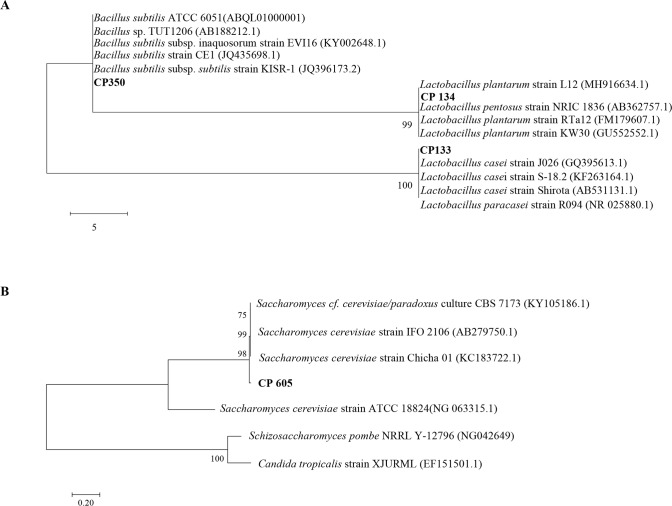
Molecular phylogenetic analysis showing the relationship of strains of CP133, CP134 and CP350 based on 16S rRNA A. and CP605 based on ITS B. using the maximum-likelihood method [32, 33]. Bootstrap values of 500 replicates are shown at the tree nodes, as generated using MEGA 7. The scale bar corresponds to 5 units (A) and 0.20 units (B) of the number of base substitutions per site.